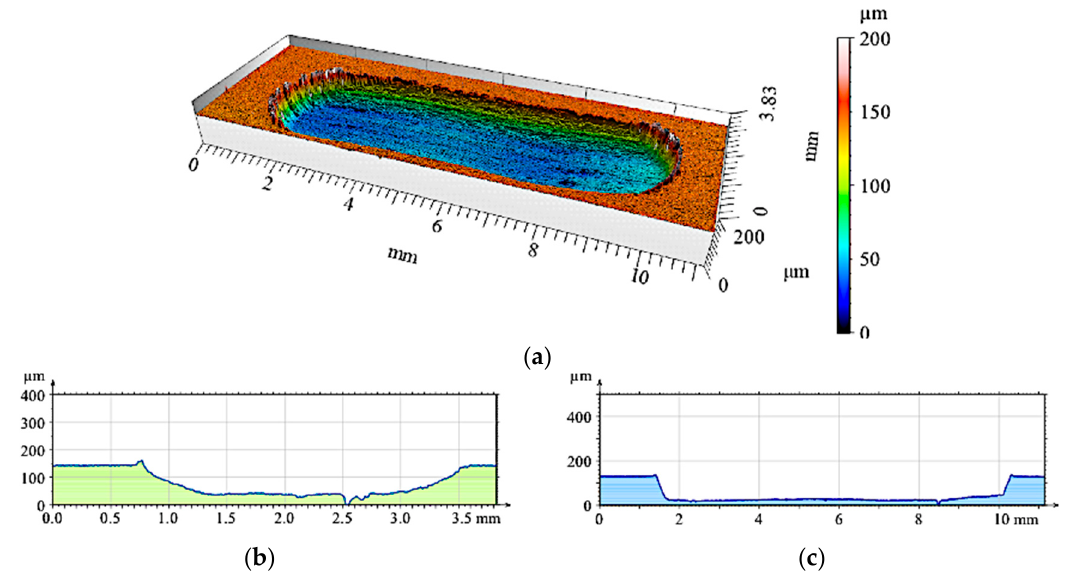
Figure 18. The surface geometry of the single composite layer (S15) after working with a cast iron pin: ( a ) View of the wear track; ( b ) Roughness distribution across the friction direction; ( c ) Roughness distribution along the friction direction.